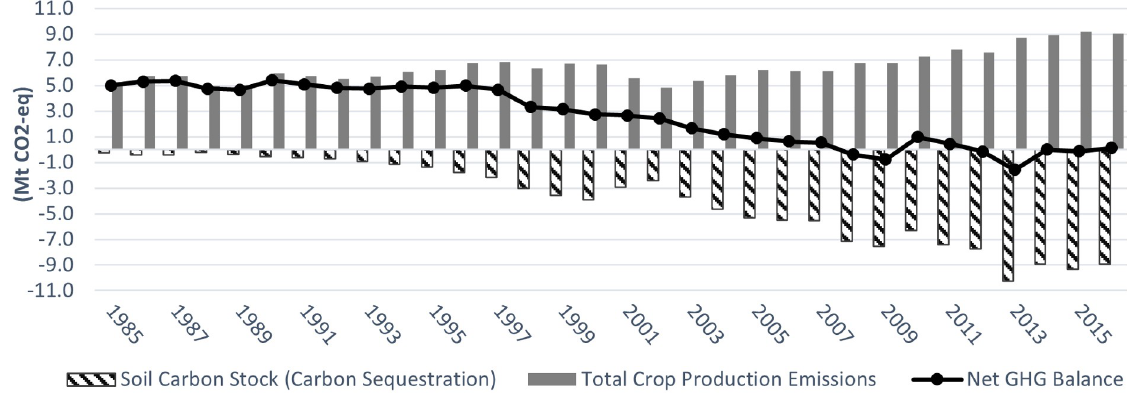
Fig 4. Saskatchewan GHGs estimates in the crop sector (Mt CO2-eq)